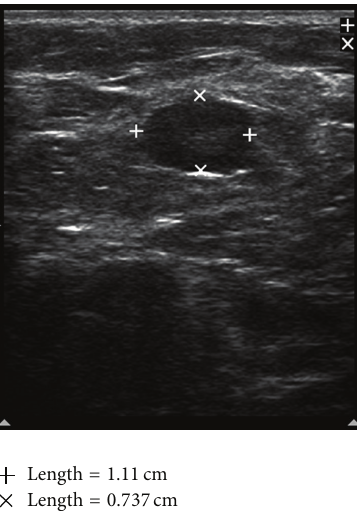
Figure 4: Suspicious node: sharply demarcated borders, asymmet- ric cortical thickening, and displaced